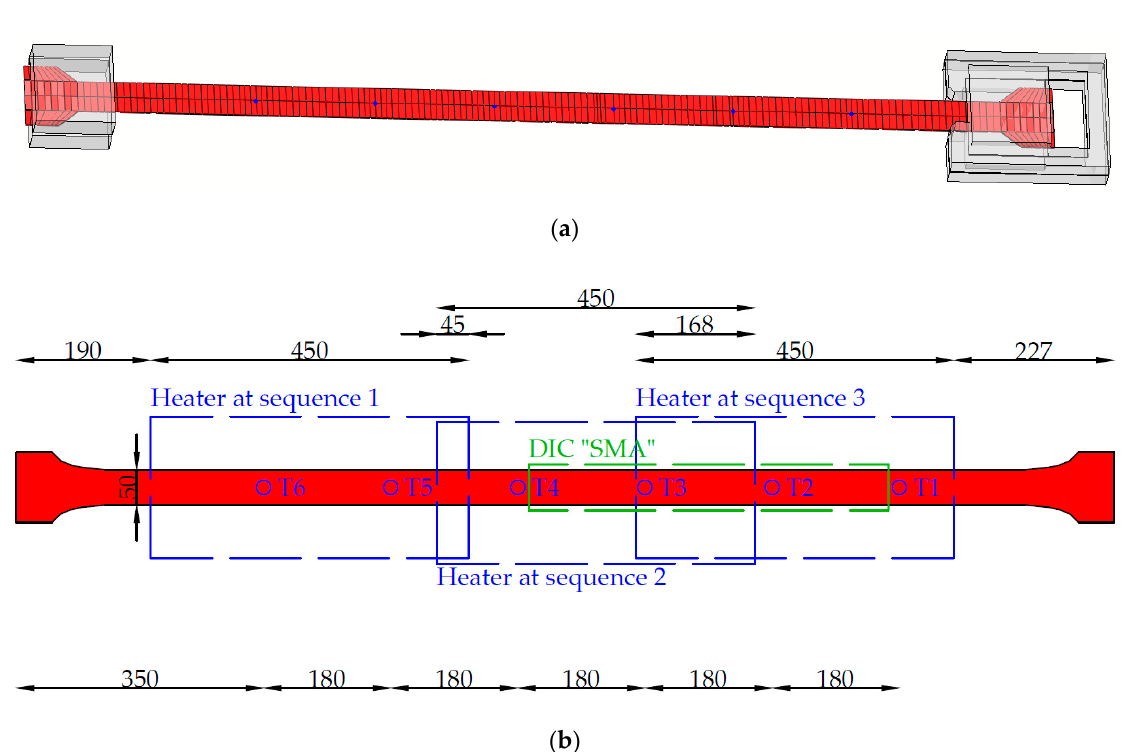
Figure 14. Thermal finite element (FE)-model, ( a ) mesh, and ( b ) geometry and monitoring points, sample SMA_1.